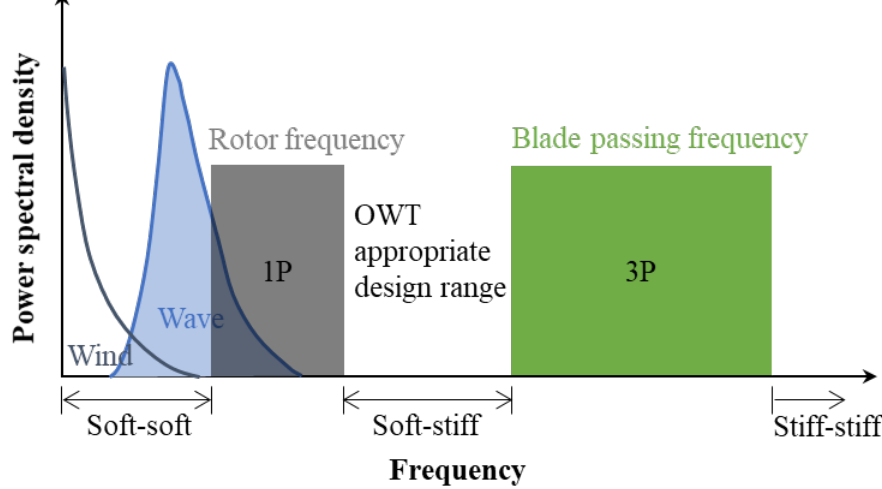
Figure 2. Frequency of a three-bladed wind turbine.